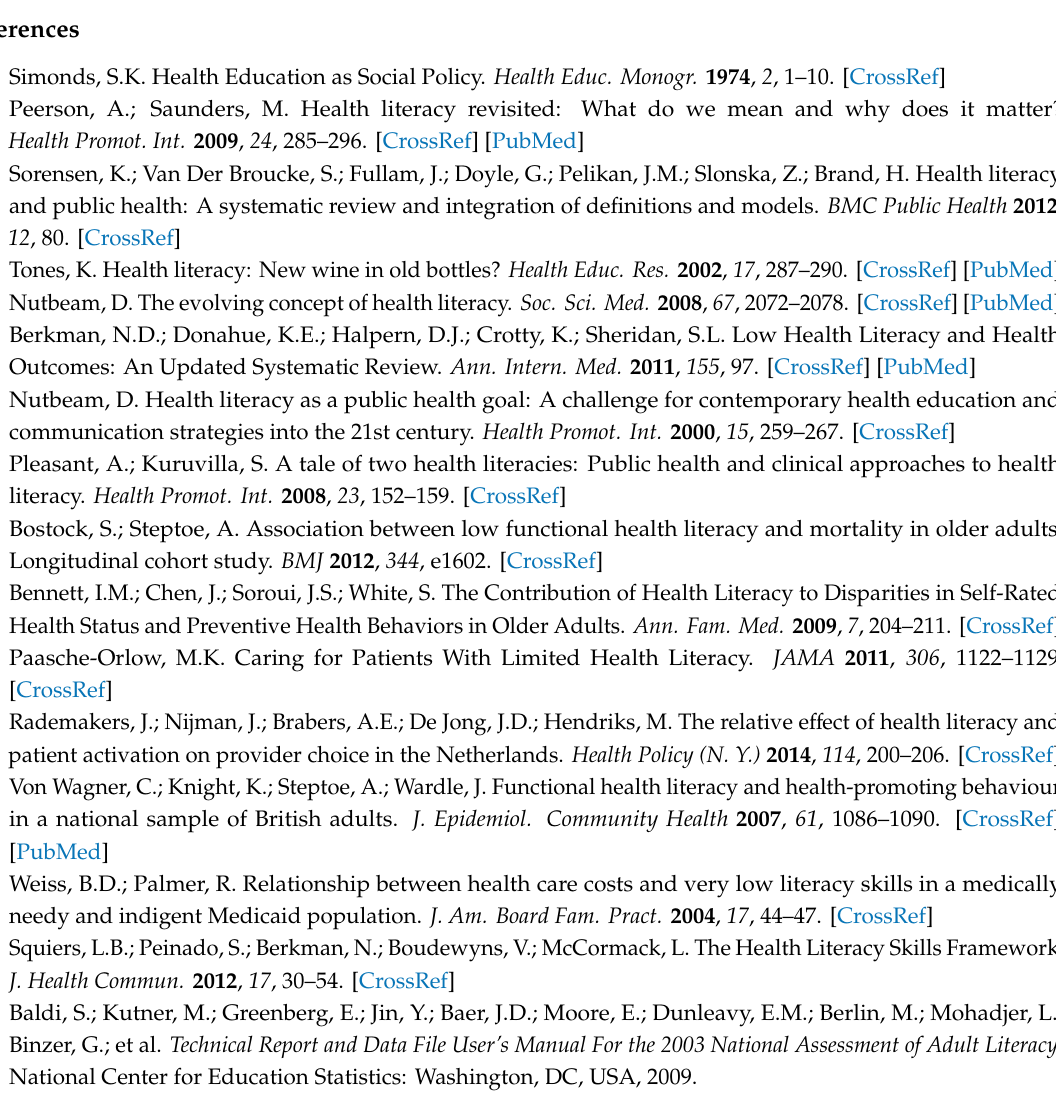
Table S1: Di ff erences in HL scores of female and male participants grouped by educational field with related p and d